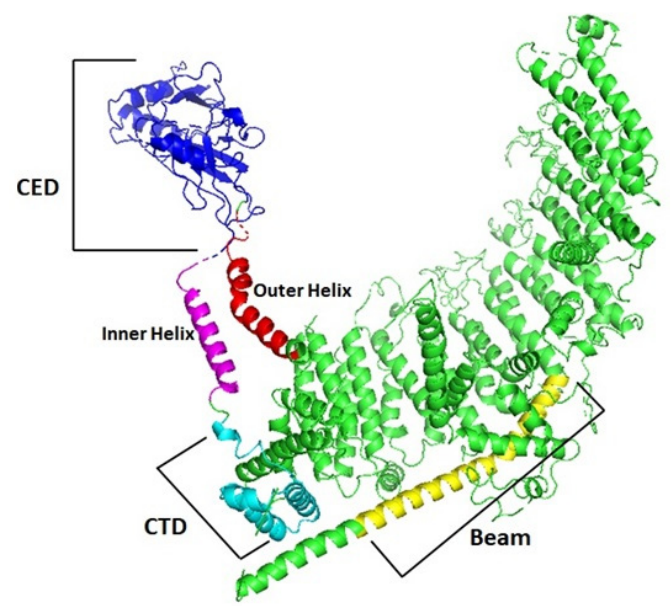
Figure 5. The three-dimensional structure of TaPiezo1-A protein. The figure displays the predicted Figure 5. The three ‐ dimensional structure of TaPiezo1 ‐ A protein. The figure displays the predicted 3D structure of TaPiezo1-A protein. The beam domain, outer helix (OH), central cap domain (CED), 3D structure of TaPiezo1 ‐ A protein. The beam domain, outer helix (OH), central cap domain (CED), inner helix (IN) and C-terminal domain (CTD) are highlighted in the figure with different inner helix (IN) and C ‐ terminal domain (CTD) are highlighted in the figure with different colors.